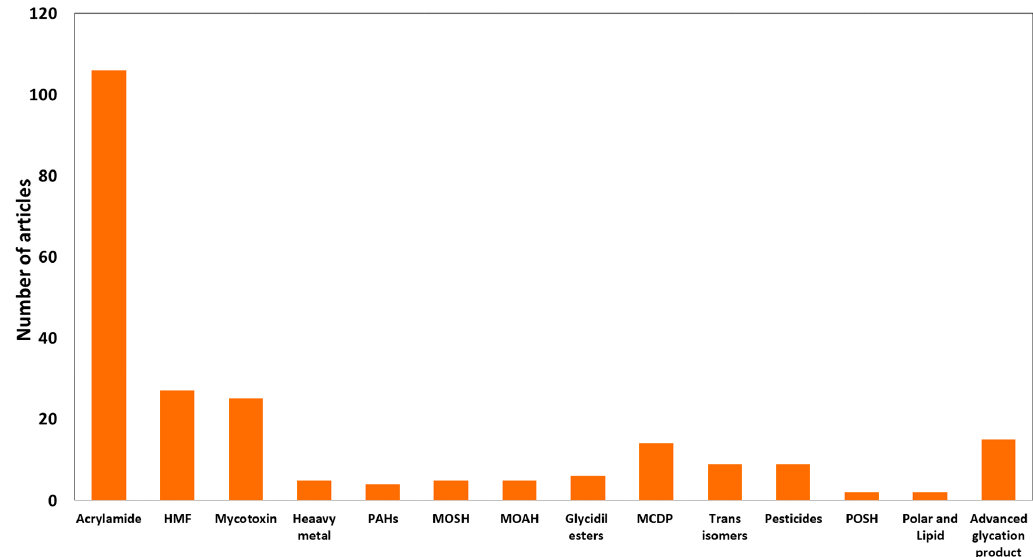
Figure 2. Number of articles published in the last decade (2012–2021) containing in the title, abstract, and keywords the words “biscuits” and the name of each contaminant. Source = Scopus database (Elsevier). HMF = 5-hydroxymethyl furfural; PAHs = polycyclic aromatic hydrocarbons; MOSH = mineral oil saturated hydrocarbons; MOAH = mineral oil aromatic hydrocarbons; MCPD = monochloropropanediol esters; POSH = polyolefin oligomeric saturated hydrocarbons.